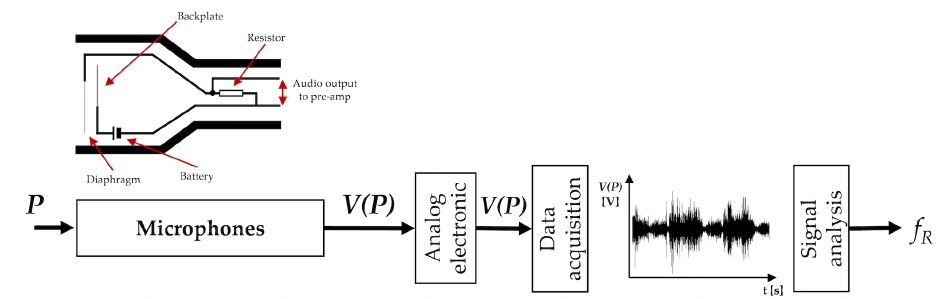
Figure 3. Acoustic sensors: the main elements composing the measuring chain (sensor, analog electronics, data acquisition, post-processing or signal analysis stage) to estimate f R . P is the acoustical pressure; V ( P ) is the voltage output. The acoustic sensor scheme is adapted from